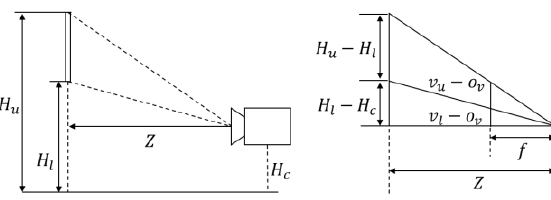
Figure 8. Side view of road sign, virtual camera, and road surface.